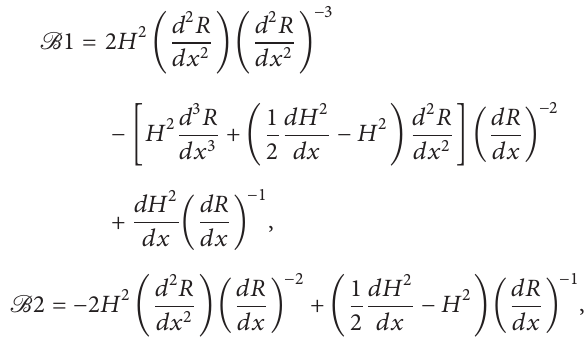
( 𝑓(𝑅) theory and DE models) reconcile as they represent distinct features of the same